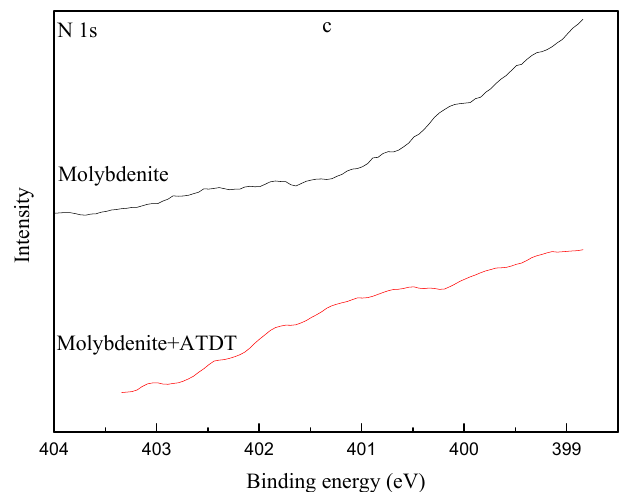
Figure 10. N 1s spectrum of ( a ) the ATDT, ATDT-Cu 2+ complexes; ( b ) the chalcopyrite before and after treatment; ( c ) the molybdenite before and after treatment.